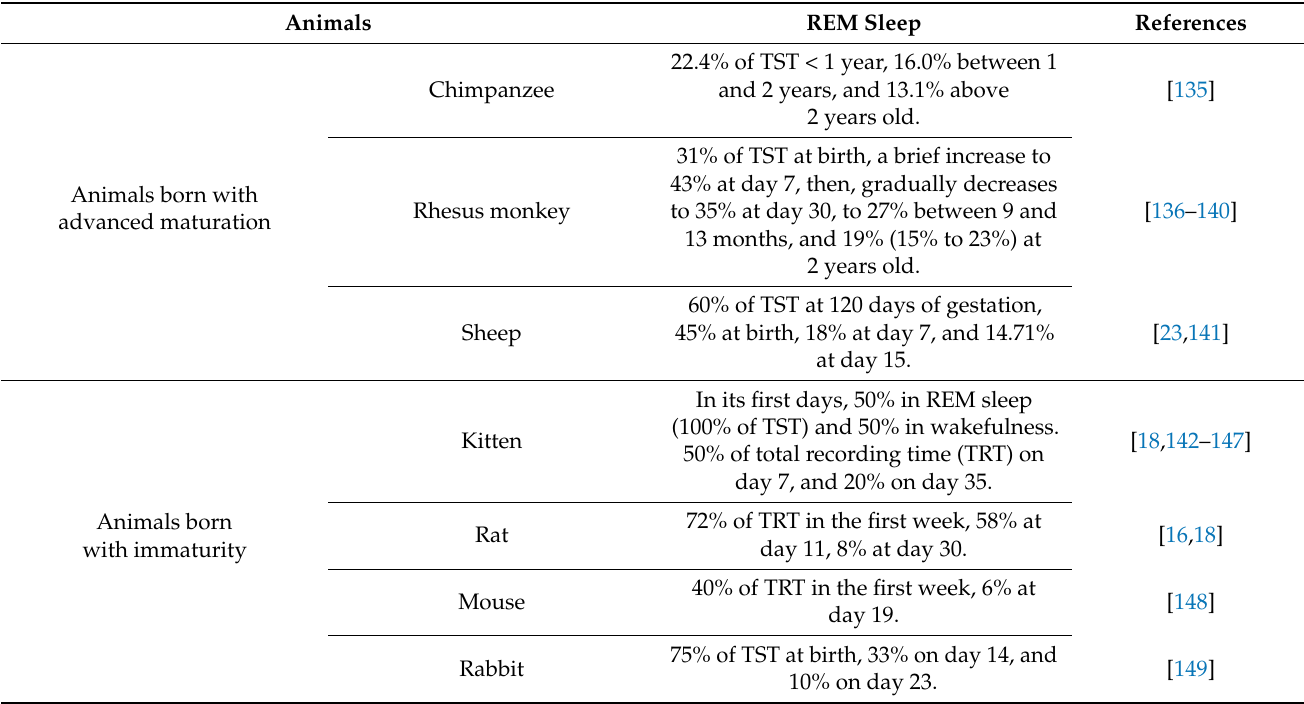
Table 3. Changes in amount of REM sleep during early development in animals.